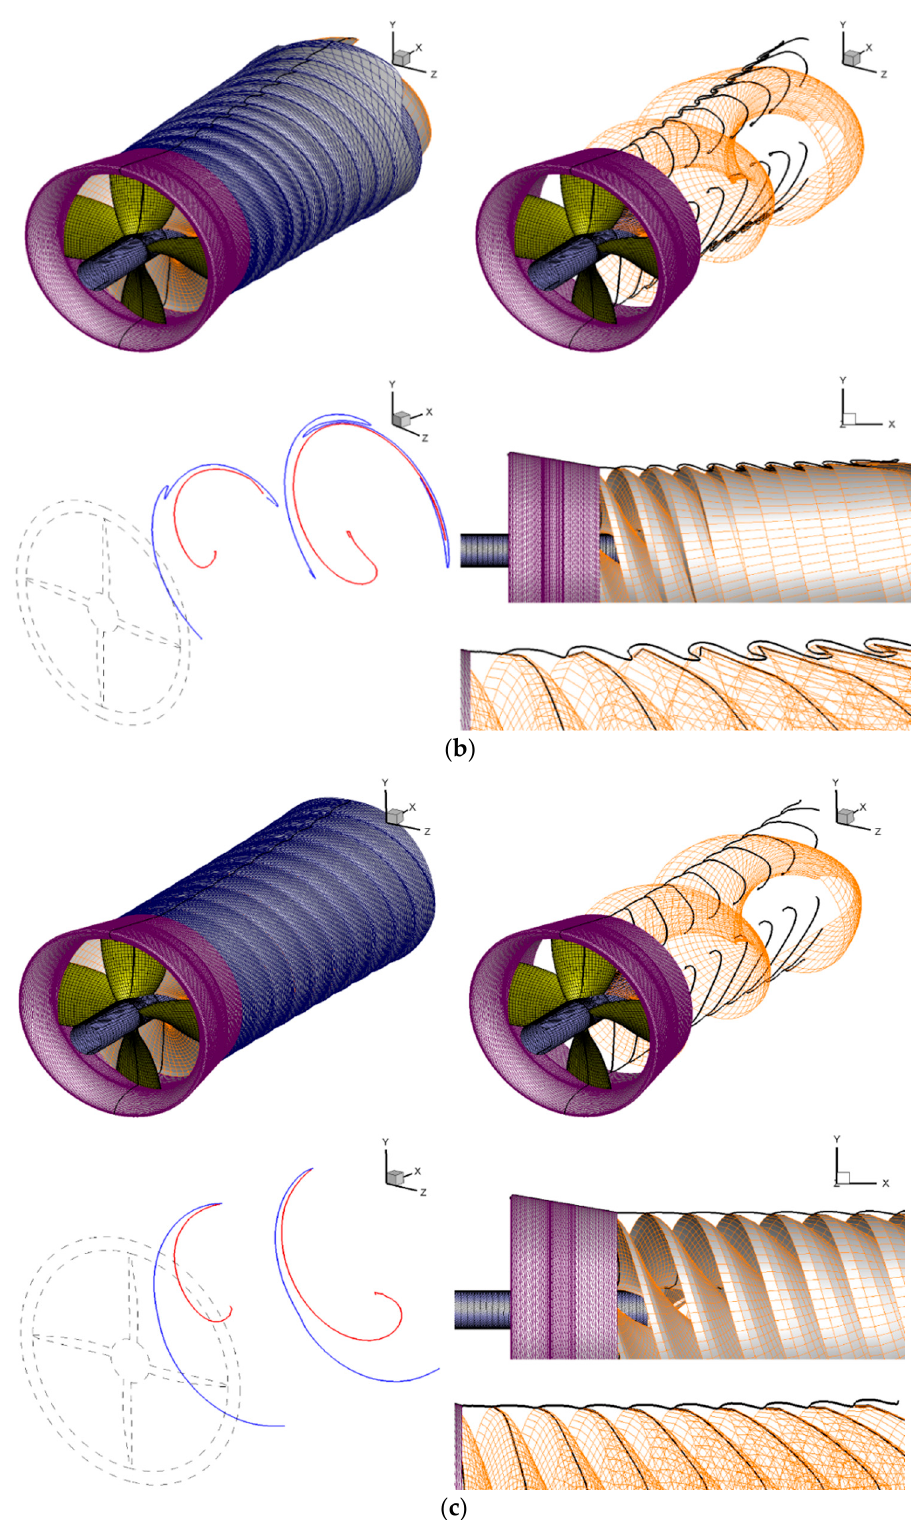
Figure 9. Converged blade and duct wake geometries from using full wake alignment on both, at ( a ) J s = 0.3, ( b ) J s = 0.5, ( c ) J s = 0.7. Perspective views of the blade and duct wakes are shown together with their intersections with vertical planes through or perpendicular to the propeller axis.